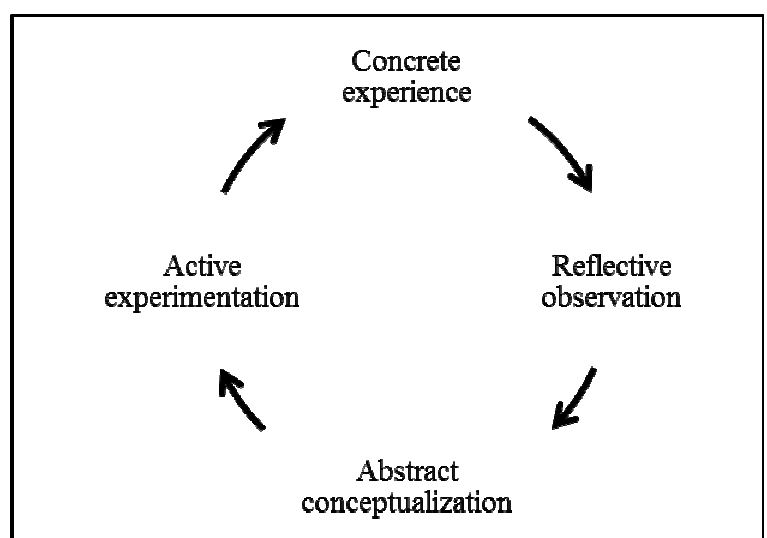
The four-stage experiential learning cycle (Kolb,